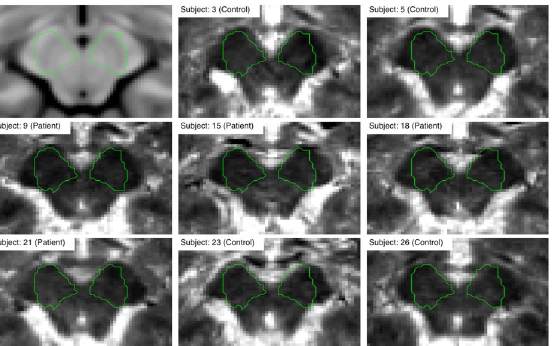
Fig 2. Registration performance for the example T 1 quantitative image. The green outline represents the rough contour of the search region.